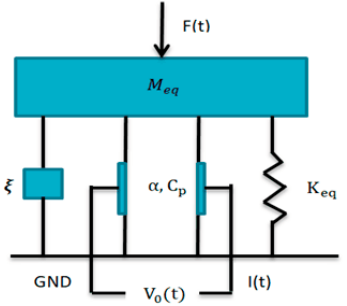
Figure 2. Equivalent model of piezoelectric conversion. M eq is the equivalent mass, K eq is the equivalent stiffness, ξ is the damping coefficient, α is the electromechanical coupling constant, C p is the equivalent parasitic capacitance, E is the elastic modulus, I is the moment of inertia, R c is the outer radius of quarter sphere, and R L is the load resistance.